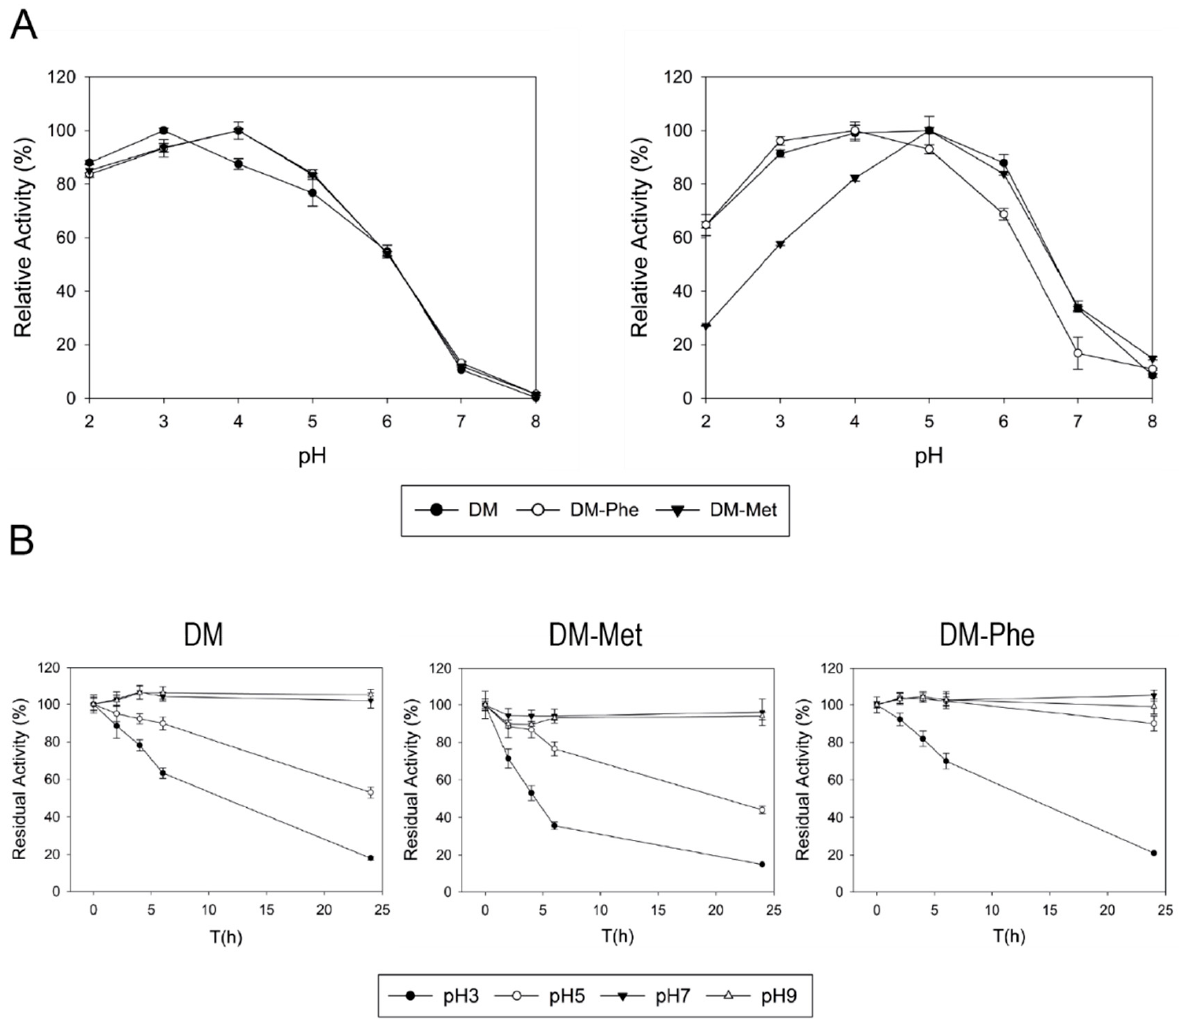
Figure 4. ( A ) pH activity profiles of DM and axial-ligand variants (DM-Phe and DM-Met) for the oxidation of ABTS (left) and DMP (right). ( B ) pH stabilities of, from left to right, DM, DM-Met and DM-Phe.